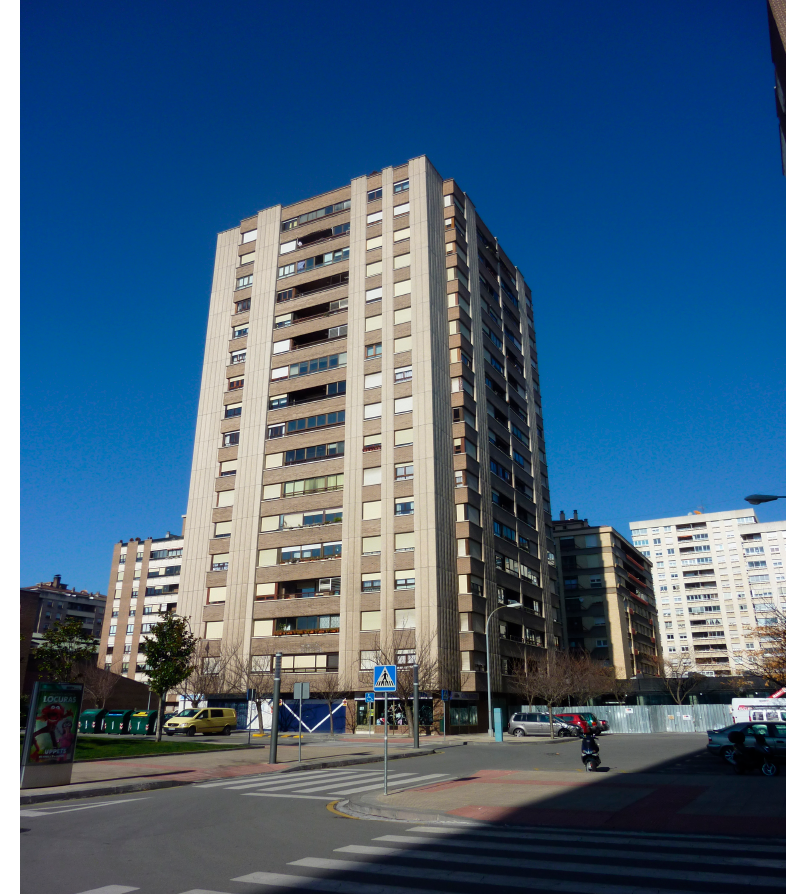
Figure 1 . Case study tower’s photo. Figure 1. Case study tower’s